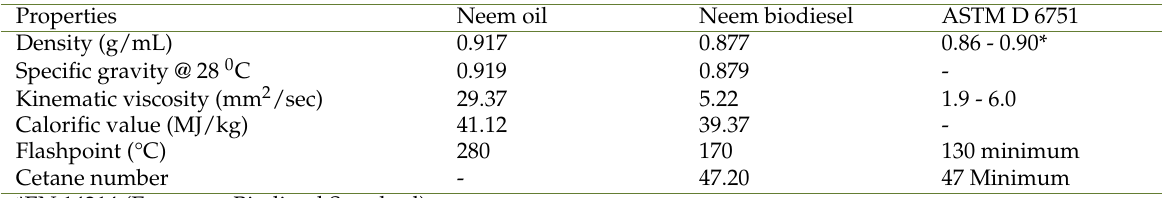
Table 3. Physical and chemical properties of raw Neem oil and its biodiesel.